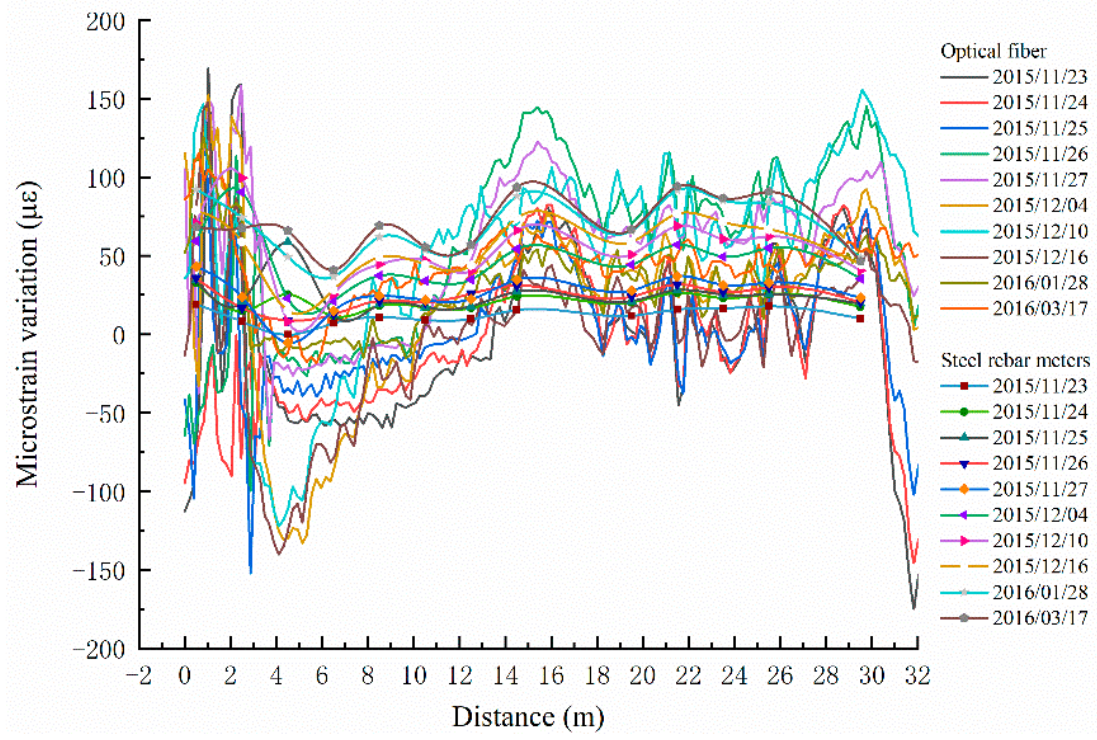
Figure 7. Comparison diagram of MS2 optical fiber and steel rebar meters.